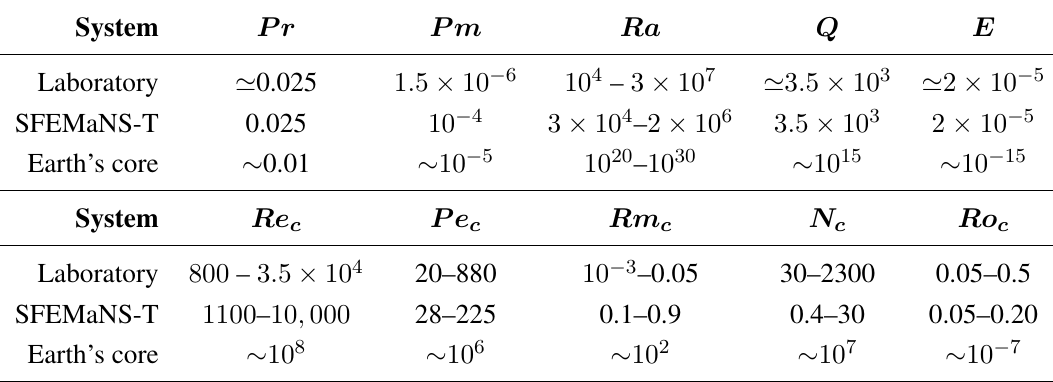
Table 2. Parameter value estimates in laboratory experiments, numerical experiments and, for example, in Earth’s core. In the bottom row, “convective” values are not given. Instead, we use observational estimates of the Reynolds number, Re , in Earth’s core [5], and then use this in making convectional estimates of the other bottom row parameter